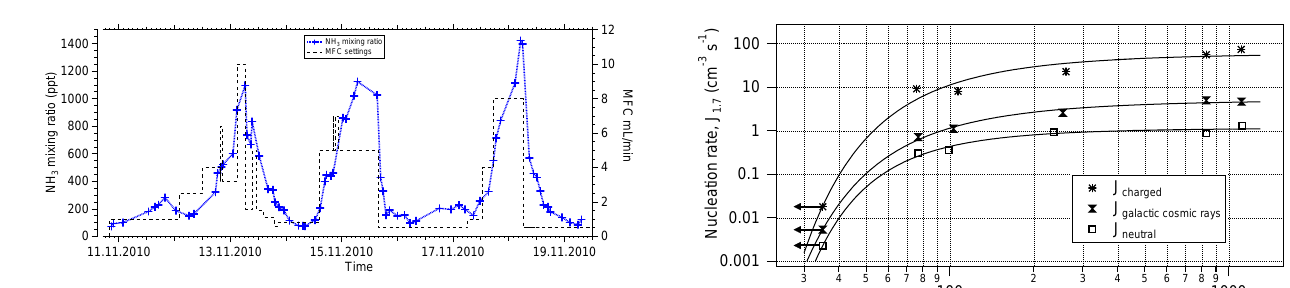
Fig. 5. Mass flow controller (MFC) settings of the ammonia inlet and the ammonia mixing ratio during the campaign.